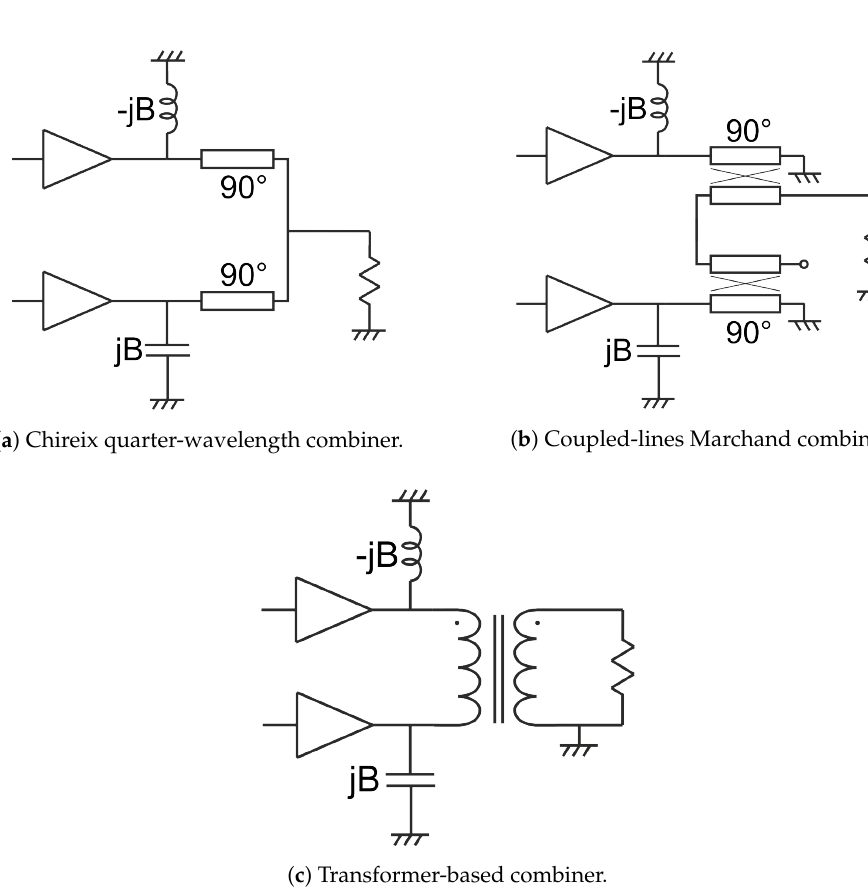
Figure 14. Typical balun topologies adopted for the Chireix PA output